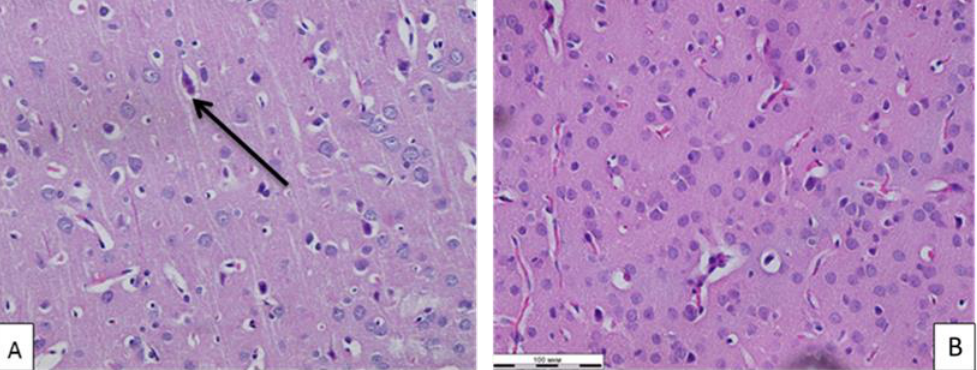
Figure 3. Microphoto of brain tissue of white rats of experimental ( A ) and control ( B ) groups. ↑ — degeneratively altered neuron. Hematoxylin – eosin. Mag. ×400.